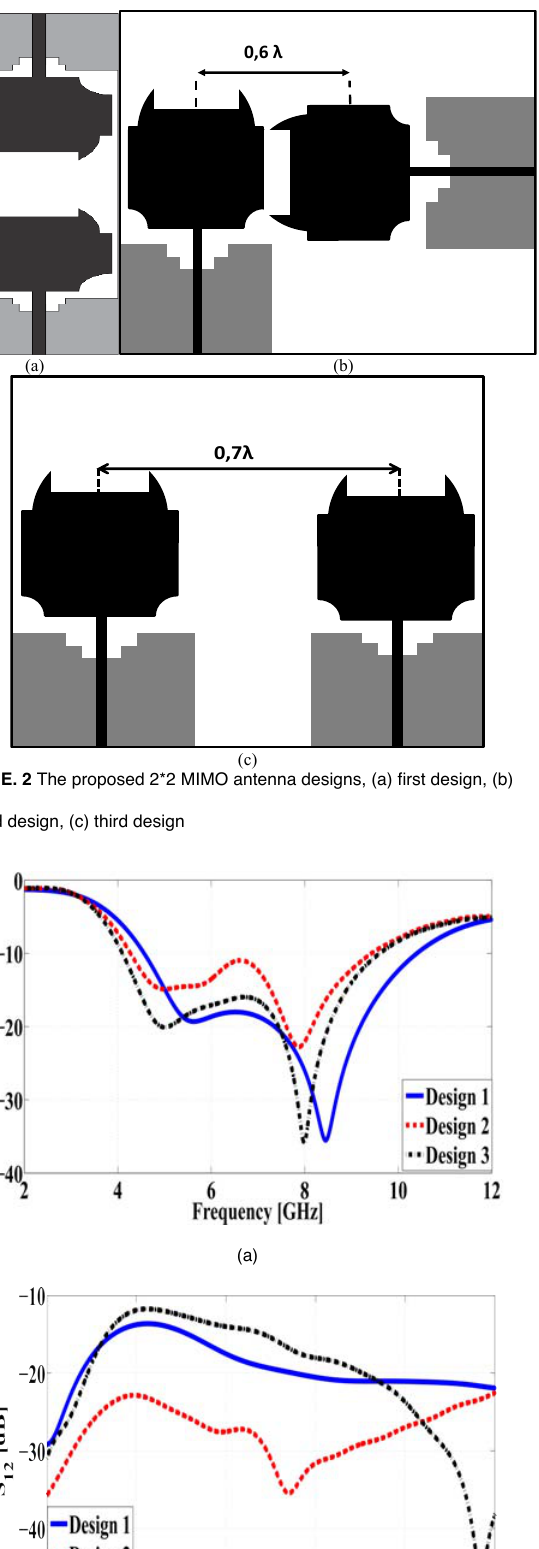
FIGURE. 3 Simulated S-parameters of the proposed three configurations, (a) reflection coefficients, (b) mutual